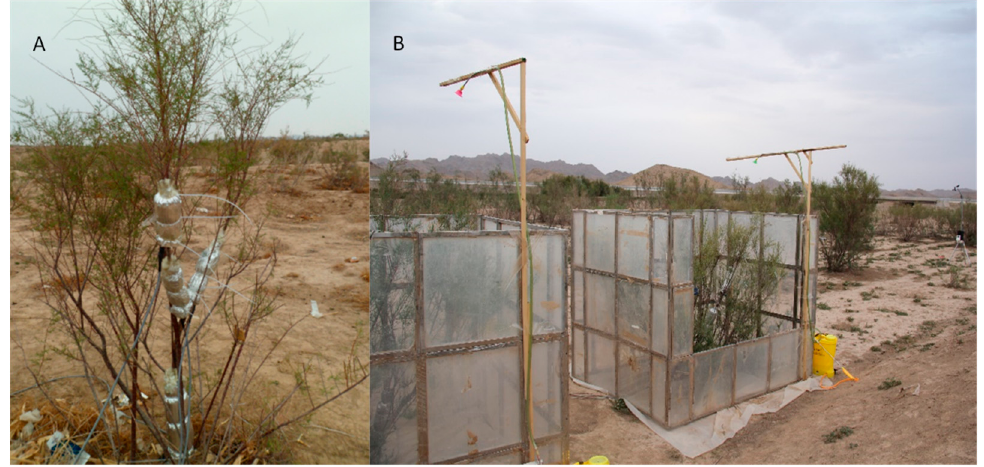
Figure 3. In-site observation settings of the experimental observation field (( A ) was the Tamarisk in the in-situ state, and ( B ) was the Tamarisk in the humidified control room).